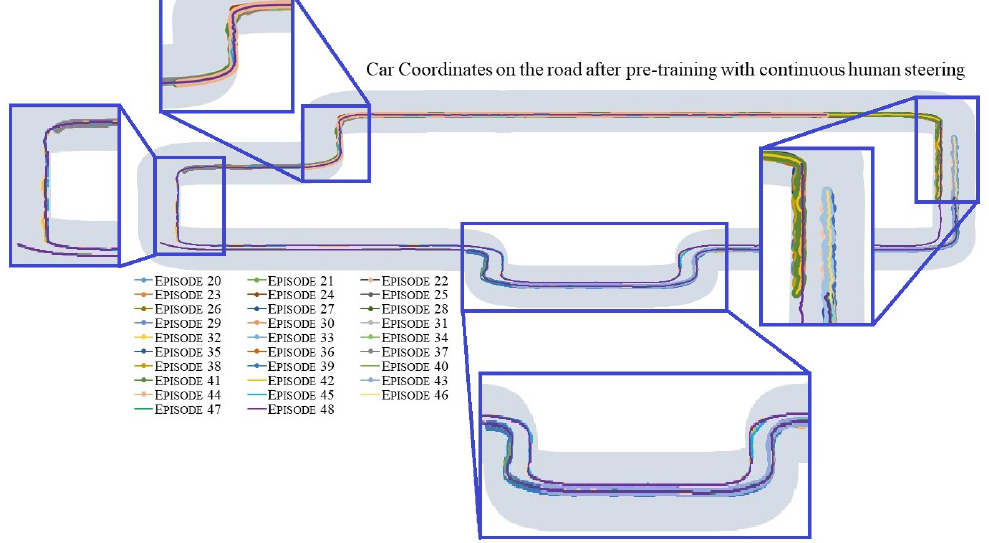
Figure 8. SAC + Continuous Steering Feedback: the car’s trajectory on the roadway after pre-training the SAC by 5000 steps of continuous human steer feedback. Four zoomed-in overlays show details of some busy parts of the